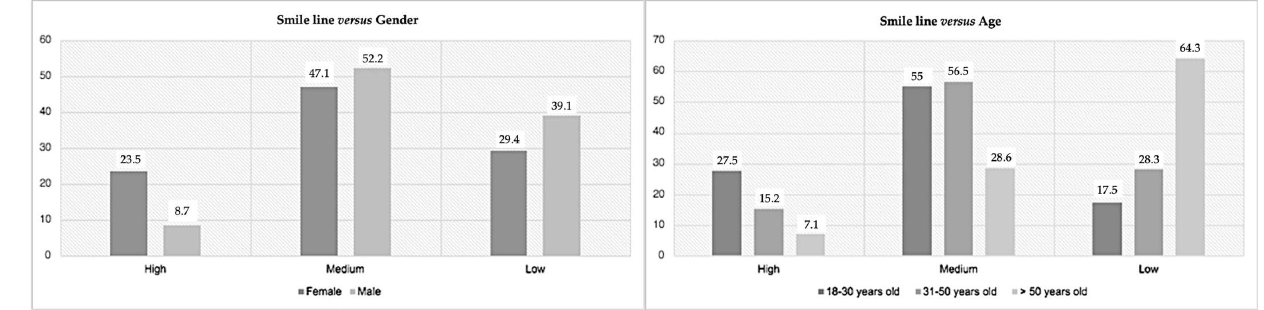
Figure 3. Prevalence of the smile line according to gender ( left ) and age ( right ).